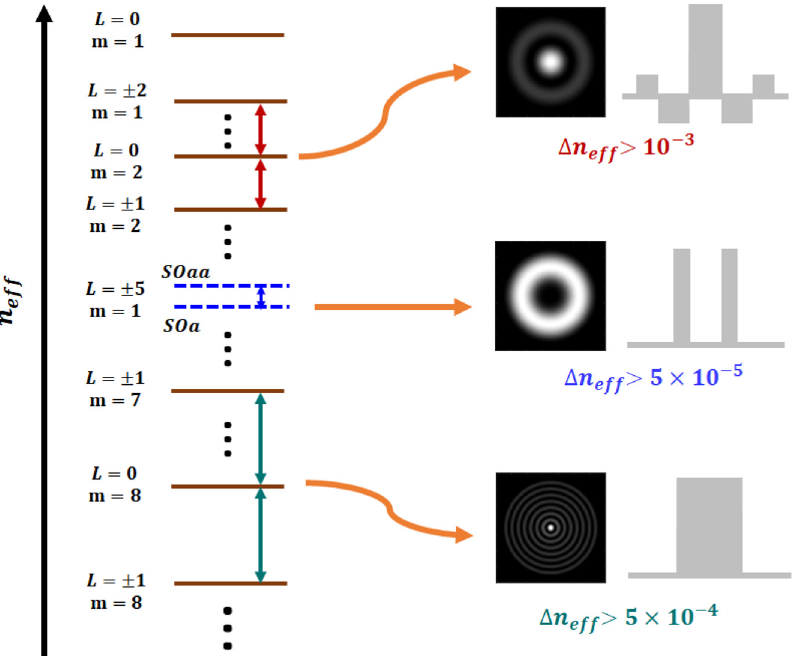
Figure 3: n eff distributions for select modes with indices L and m . For visual clarity, not illustrated are polarization degeneracies of any of the modes or the n eff degeneracies of any except for the | L | = 5 mode. Orange arrows leading to representative mode images for corresponding fi ber designs (gray shaded features) describe mode separations (quanti fi ed by Δ n fi bers. The eff ) for a select class of modes in their respective n eff of the LP 0,2 mode can be separated from LP 2,1 and LP 1,2 modes (red arrows) by using the class of “ W ” shape fi ber designs, enabling its stable propagation for dispersion controldesigns. The n eff splitting of | L | = 5 OAM modes (blue arrow) can be at least 5 × 10 − 5 in ring-core fi ber designs, such that both | L | = 5 SOa and SOaa modes can propagate stably, yielding OAM mode stability in fi bers. The n eff splitting between LP 0,8 andits nearestneighboring LP 1, m modescanbe largerthan 5 × 10 − 4 insimplestep-index fi bers (greenarrows), enablingstable guidance of modes with large A eff